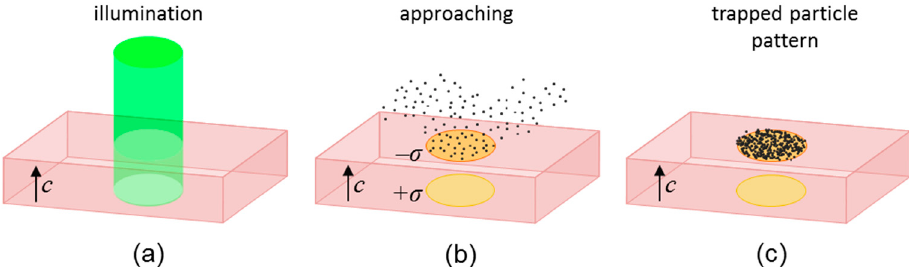
Figure 1. Schematics showing the operation of photovoltaic tweezers: ( a ) Illumination of the PV substrate; ( b ) approach of the particles to the substrate under DEP or EP forces; and ( c ) resulting trapped particle pattern. Steps (a) and (b) can be performed either sequentially or simultaneously.